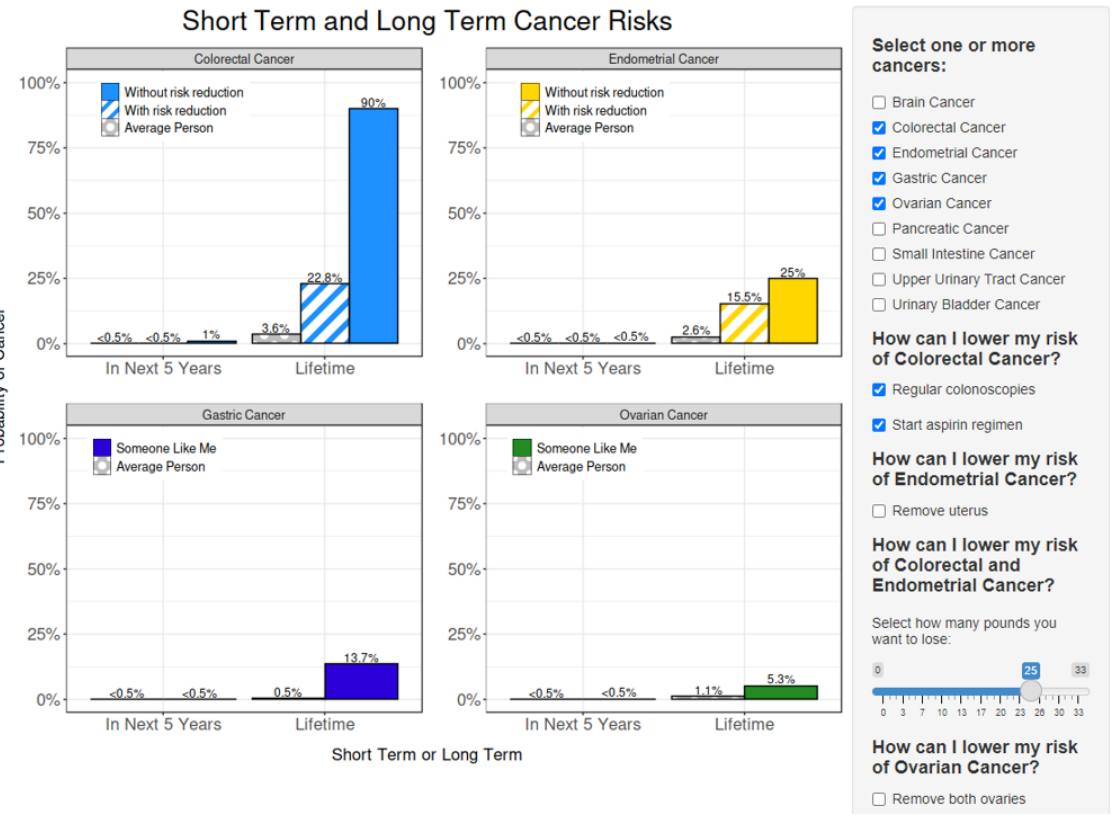
Figure 3. Screen shot from MyLynch in which the user builds their personalized cancer risk report using the bar graph visualization. The user selects options on the right, which interactively adjusts the risk visualization on the left. The figure shows CRC, endometrial, gastric, and ovarian cancer risks over time for a hypothetical 25-year-old, obese, female with an unspecified race and ethnicity, a MLH1 PV, no cancer history, and no relevant prophylactic surgical history. The hypothetical user has selected the following interventions: regular colonoscopies, an aspirin regimen, and 25lbs of weight